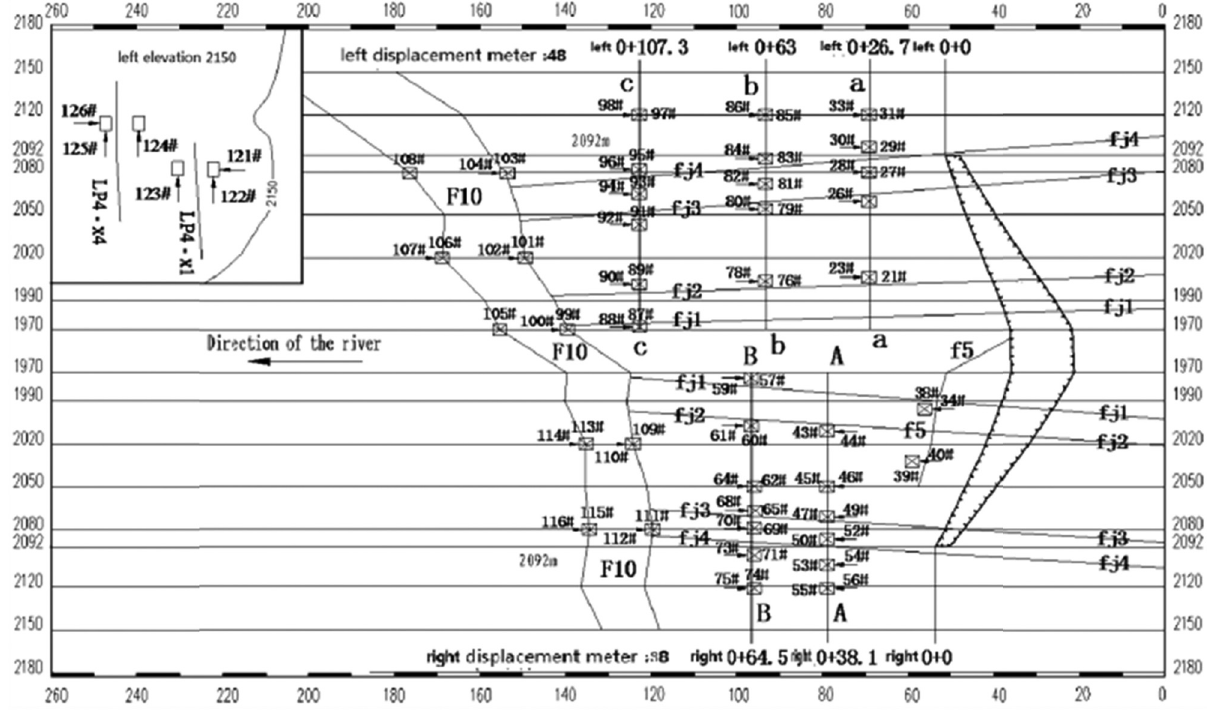
Figure 4: The layout of displacement measurement points of two dam abutments and the surface of the resistance body in the model.